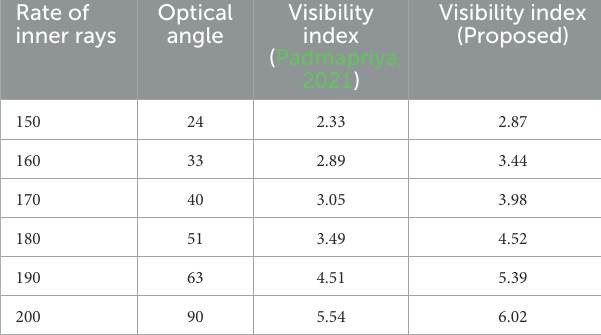
panel design, the transmission time for unnecessary links is